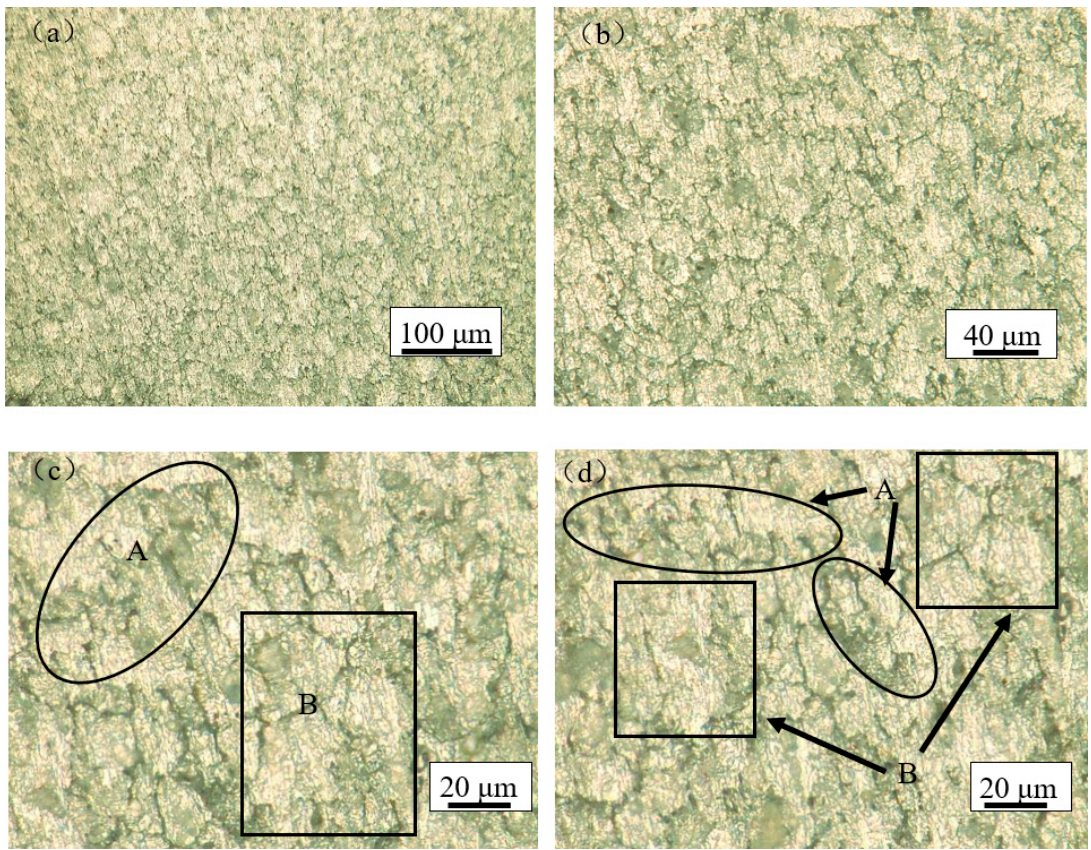
Figure 2. The microstructure of a two-layered gradient aluminum foamed cell wall under a metallographic microscope at different scales with of ( a )100 μ m, ( b ) 40 μ m, ( c ) and ( d ) 20 μ m: A—clear boundary line, B—better boundary combination.